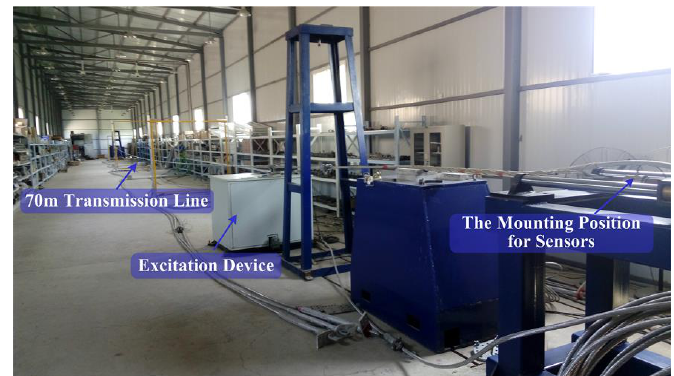
Figure 9. The setup of galloping experiment on transmission line model.